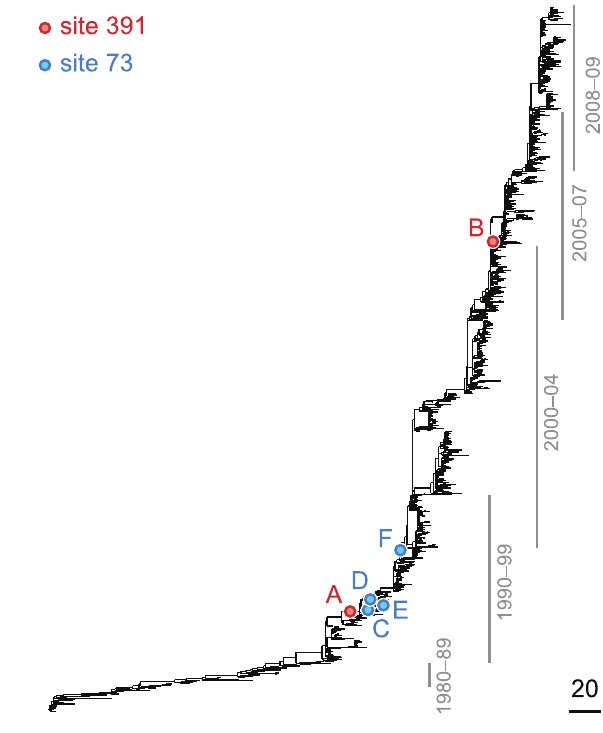
Figure 2. Phylogenetic tree of HA (subtype H3) illustrating a putatively epistatic interaction between sites 391 (red circles) and 73 (blue circles). Site 391 is not in an epitope, dN = dS ~ 0 : 47 ; site 73 is epitope E, dN = dS ~ 0 : 72 . Only substitutions at internal nodes are displayed. Branch lengths are equal to the total number of substitutions across all sites. Vertical bars show the approximate years in which the sequences were isolated. Substitutions C, D, E, and F at site 73 closely follow substitution A at site 391, leading to a highly significant value of the epistasis statistic ( E 63 (391,73) ~ 3 : 48 , nominal P - value v 10 { 4 ). As a result, the ordered pair of sites (391, 73) is detected as epistatic by our method. At the same time, only a single substitution, B, at site 391 follows substitution F at site 73 – and only after a long period of time – resulting in a low value of the epistasis statistic for the inverse pair ( E 63 (73,391) ~ 1 : 20 , nominal P - value ~ 0 : 18 ). Therefore, the ordered pair of sites (73,391) is not detected as epistatic by our method.